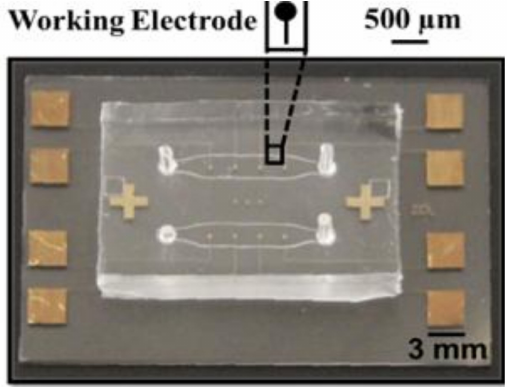
Figure A1. Optical image of a np-Au multielectrode array integrated with polydimethylsiloxane (PDMS) microfluidic channels that house the micro-scale electrodes.